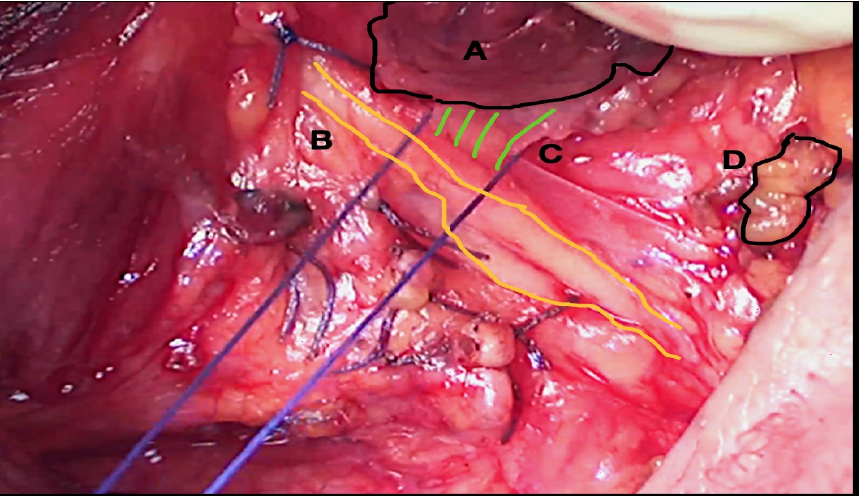
Figure 4. RLN dissection with optical magnification 4.5 × . A Thyroid gland. B Right-sided RLN identified and dissected among ligatures. C Berry’s ligament. Excessive traction during ligation may cause RLN injury. D Inferior parathyroid gland.